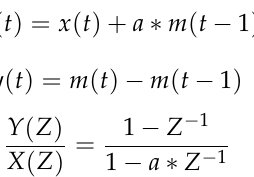
Figure 6. A flowchart of PPG signal preprocessing.